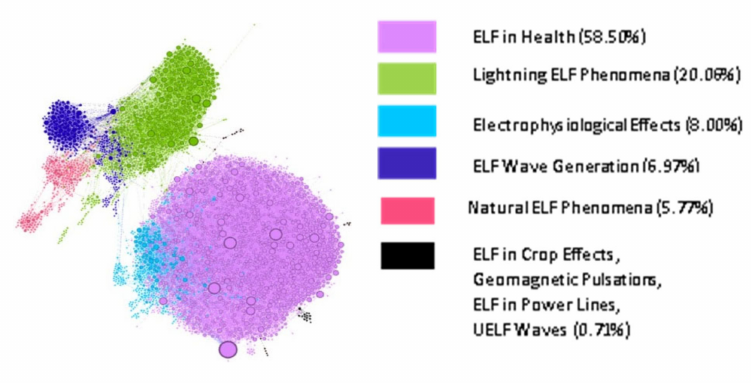
Figure 4. Representation of the communities investigating ELF